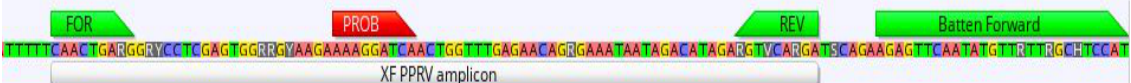
Figure 1. Location of the primers and probes of the newly developed PPR assay. The location of the forward primer of the PPR reference assay is shown to provide context. The alignment is to a consensus sequence of 300 nucleocapsid (N) gene sequences of PPRV aligned to accession number KY885100.